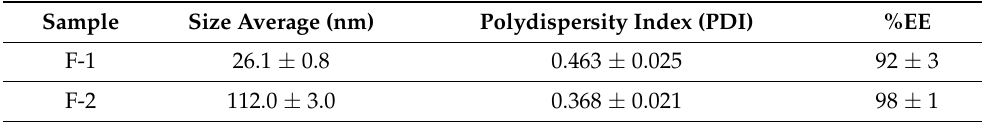
Table 2. Physical characteristics of nanoformulations F-1 and